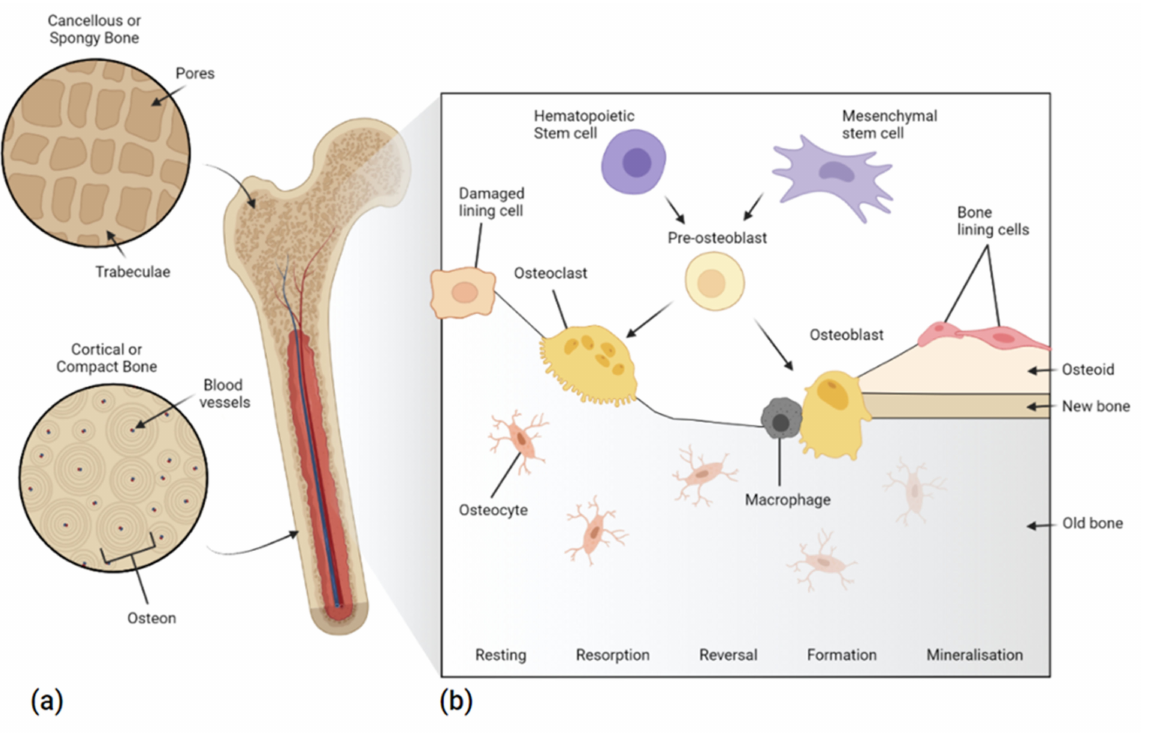
Figure 1. ( a ) Internal structure of human bone ( b ) bone remodelling and the stem cell pathway, including bone resorption by osteoclasts, bone formation, and mineralisation by osteoblasts, after which, osteoblasts become either new lining cells or mature into